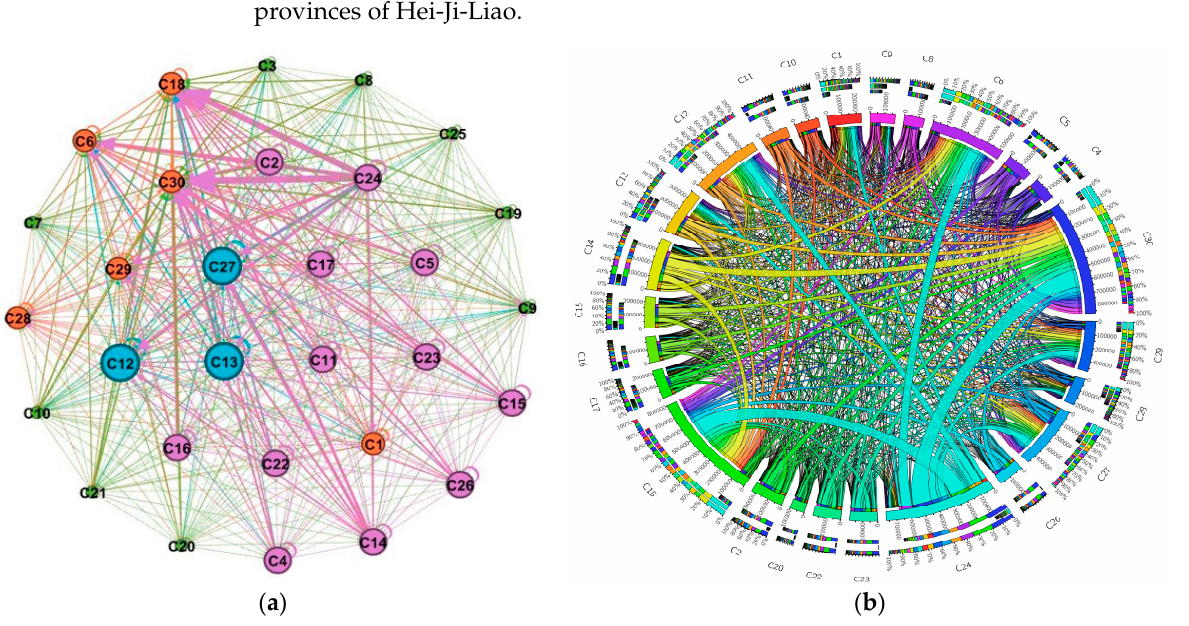
Figure 7. Graph of Embodied carbon emissions flows between industry sectors in Jilin. ( a ) Embodied carbon emissions network; ( b ) Embodied carbon emissions ring.